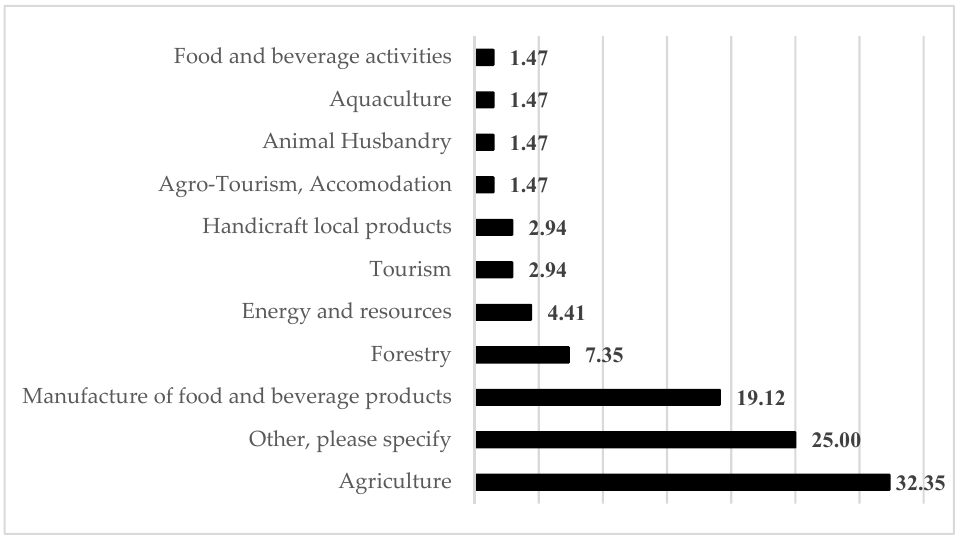
Figure 2. Sectoral background of surveyed rural SMEs. Source: own processing of survey.